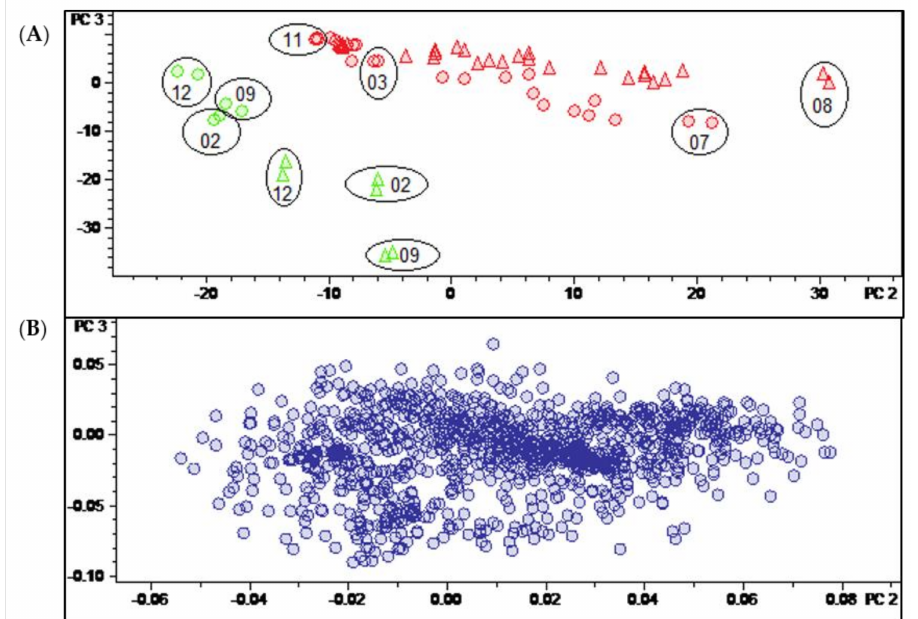
Figure 6. ( A ) Scores and ( B ) loadings plot of the PCA model obtained with unit variance-scaled variable data. PC2 (explaining 12.6% of the total variance in the data) and PC3 (explaining fur- ther 7.9% of the total variance). Legend for ( A ): round dots = B . sempervirens var. suffruticosa ; triangle = B . sempervirens var. arborescens ; red = leaf; green = twig; number = month; circle = related technical replicates ( n = 2; quality control (QC) n = 4).